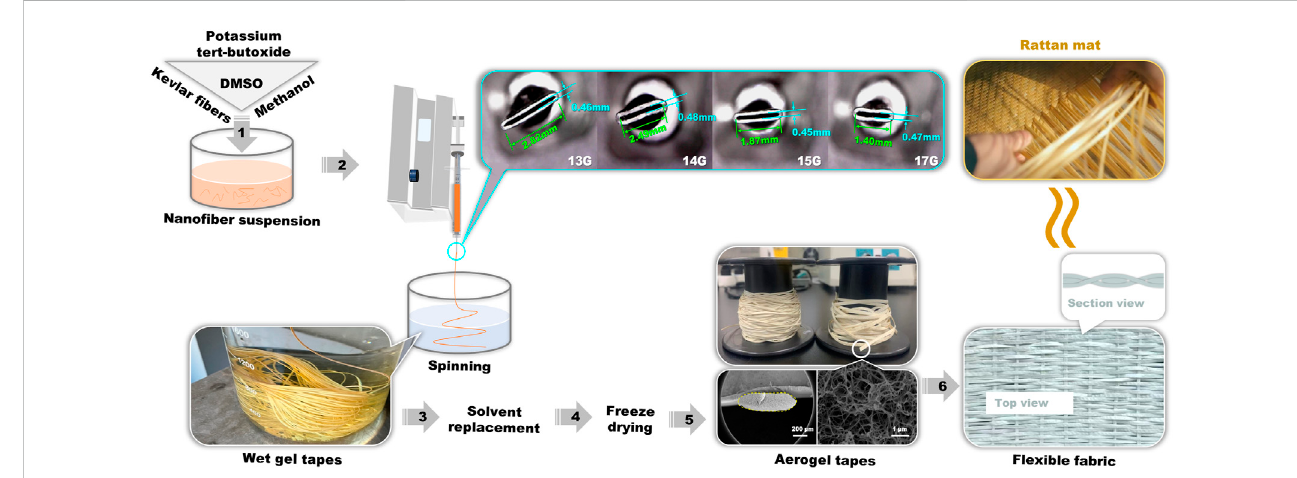
FIGURE 1 Process of fabricating Kevlar aerogel tapes with fl attened needles of different sizes, and the appearance of the fabric braided from the